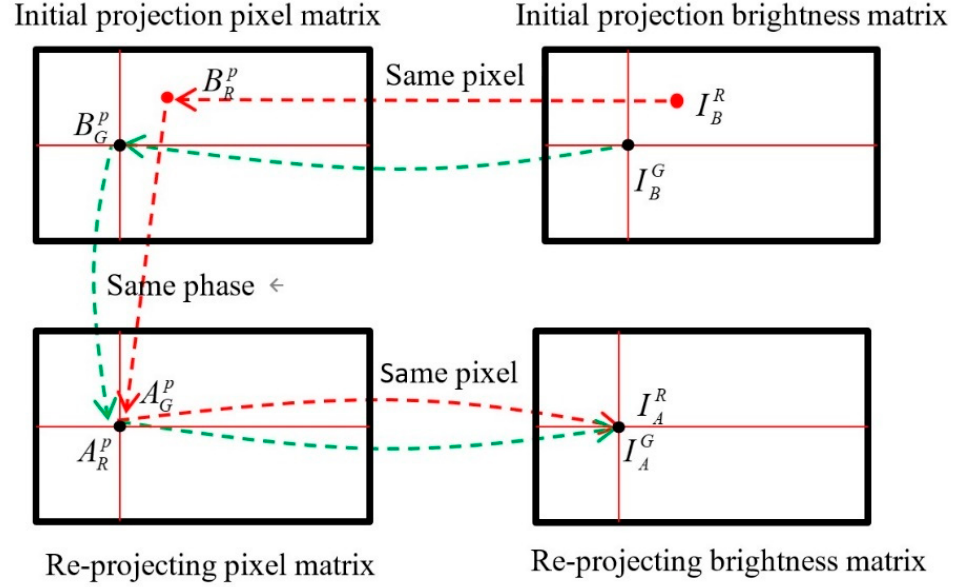
Figure 7. Schematic diagram of brightness matching.